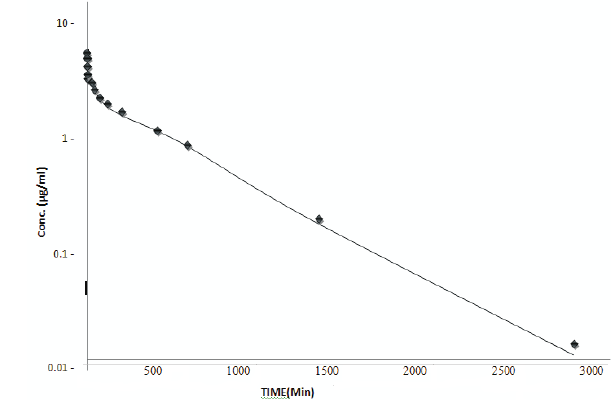
Figure-1. Plasma concentration of Meloxicam in HPLC data system after IV administration Table-1. Plasma concentrations (µg/ml) of Meloxicam in goats after intravenous administration at the dose rate of 1 mg/kg body weight.*(n=5) Time (minutes) Animals* Mean +